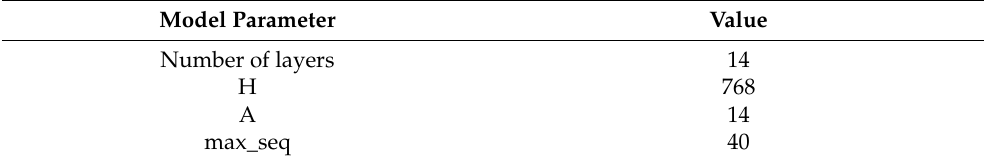
Table 2. Chinese BERT model